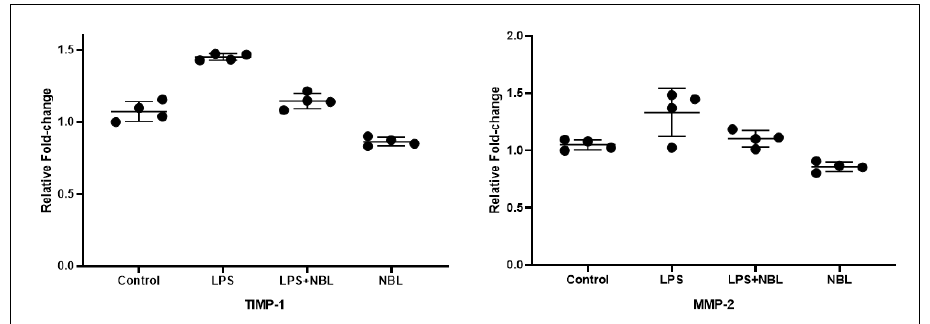
Figure 5. TIMP-1 and MMP-2 Levels in Lung Tissue. LPS: Lipopolysaccharide; NBL: Nebivolol; TIMP-1: TIMP Metallopeptidase Inhibitor 1; MMP-2: Matrix Metalloproteinase-2. Expression data were calculated relative to saline control.